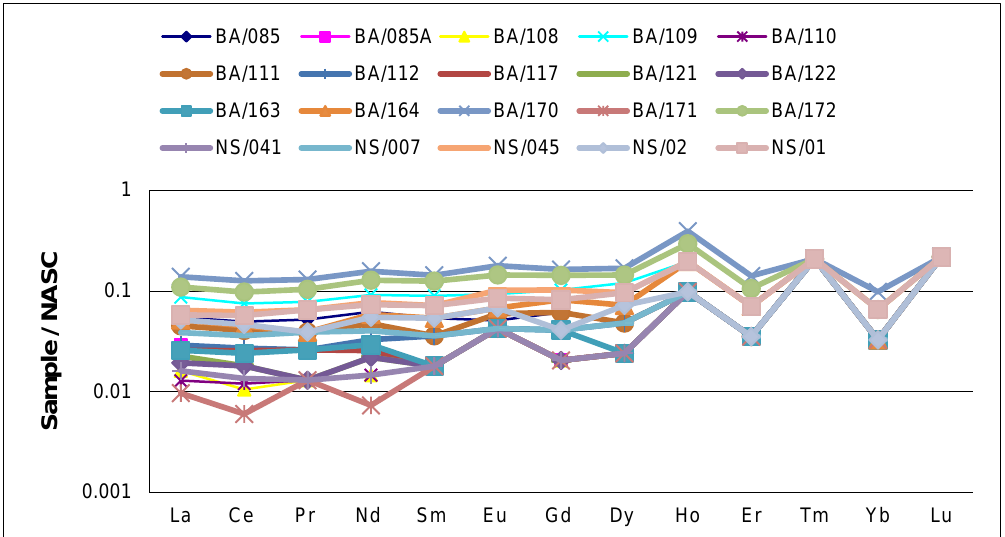
Figure 6. North American Shale Composite (NASC) normalized rare earth element (REE) patterns of the rock samples of the study area.